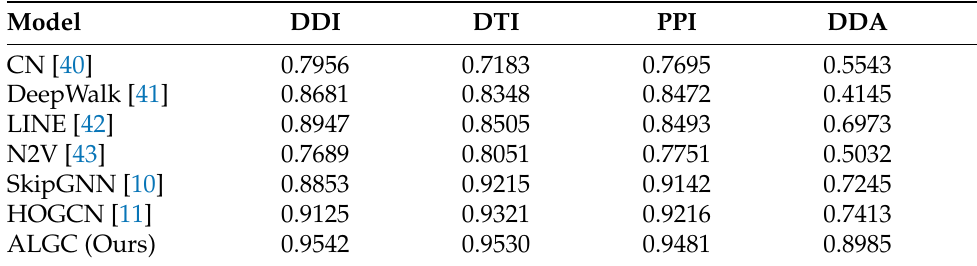
Table 2. Comparison with baselines on training percentages (70%) (AUROC).